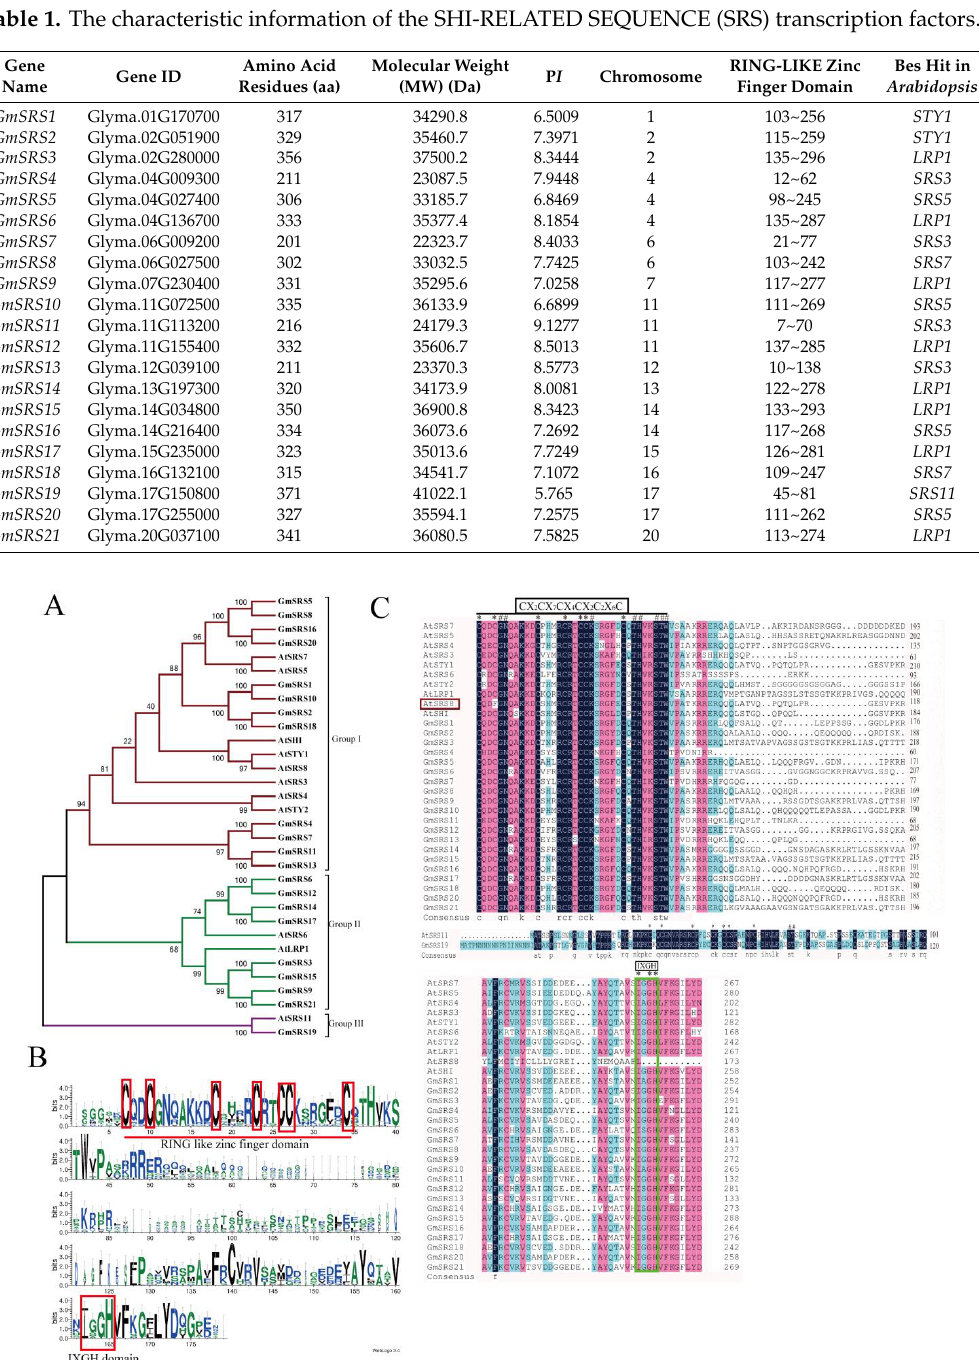
Figure 1. Phylogenetic relationship and predicted structures of SRS family proteins in soybean and Arabidopsis . ( A ) Neighbor-joining phylogenetic tree of the SRS family in soybean and Arabidopsis . ( B ) The conserved RING-like zinc finger domain (CX 2 CX 7 CX 4 CX 2 C 2 X 6 C) and the IXGH domain. The predicted domain sequence was obtained from the website PlantTFDB v5.0 (http: // planttfdb.cbi.pku.edu.cn / ) ( C ) Alignment of SRS proteins in soybean and Arabidopsis